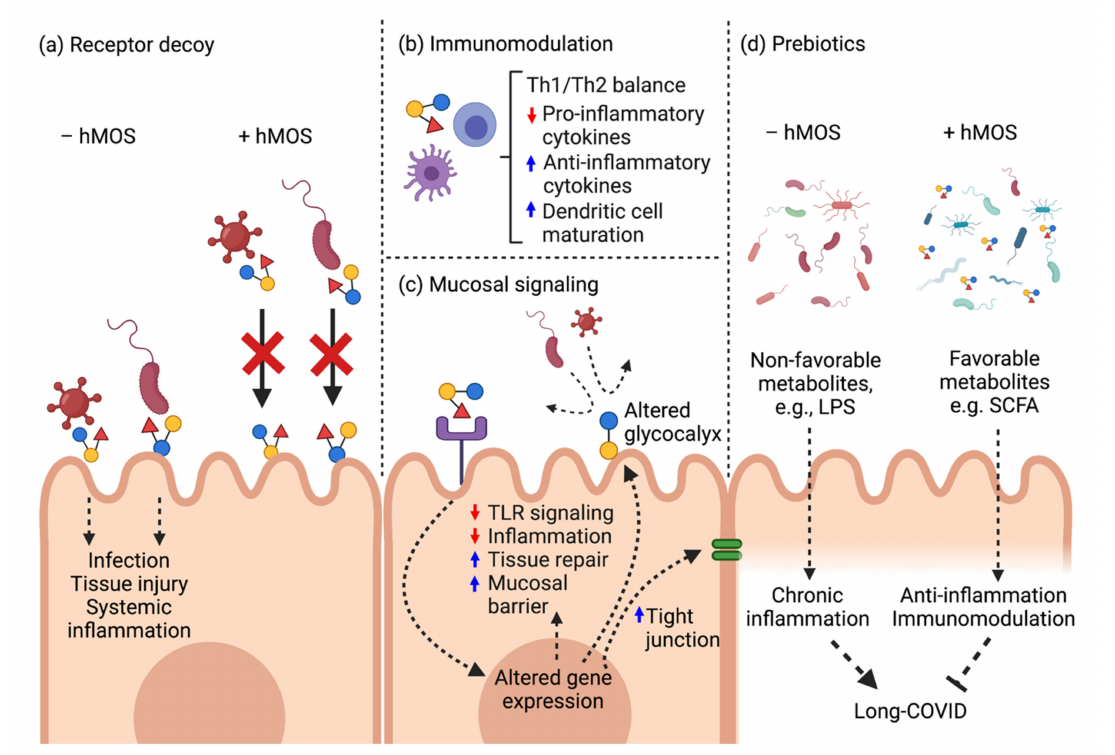
Figure 2. Potential modes of action of hMOS against SARS-CoV-2. ( a ) HMOS molecular structures are analogous to HBGAs and act as receptor decoys to block viral entry. ( b ) HMOS induce local defense and immumomodulation. ( c ) HMOS attenuate TLR4-mediated signaling pathways to maintain mucosal homeostasis. ( d ) HMOS mitigate gut dysbiosis and restore healthy gut microbiota in